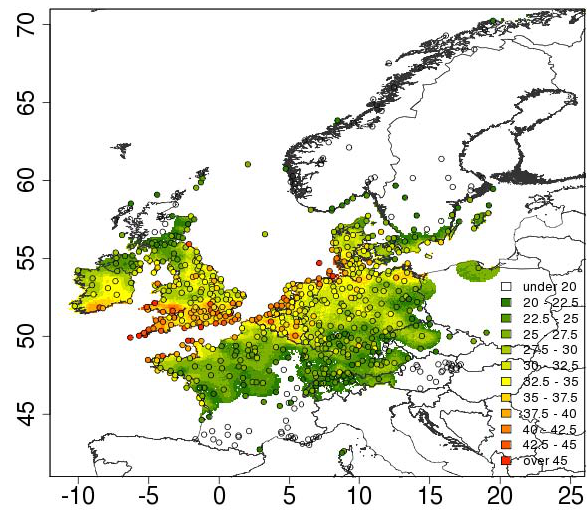
Fig. 2. Map of 3 s peak gusts [ms − 1 ] at the variable resolution grid (VRG) for storm Daria on 25 January 1990. Circles represent the location of weather stations. Note that gusts at the VRG are weighted towards areas with exposure, hence rougher surfaces than station measurements which tend to be over open terrain, leading to a 10% reduction in gust strengths in